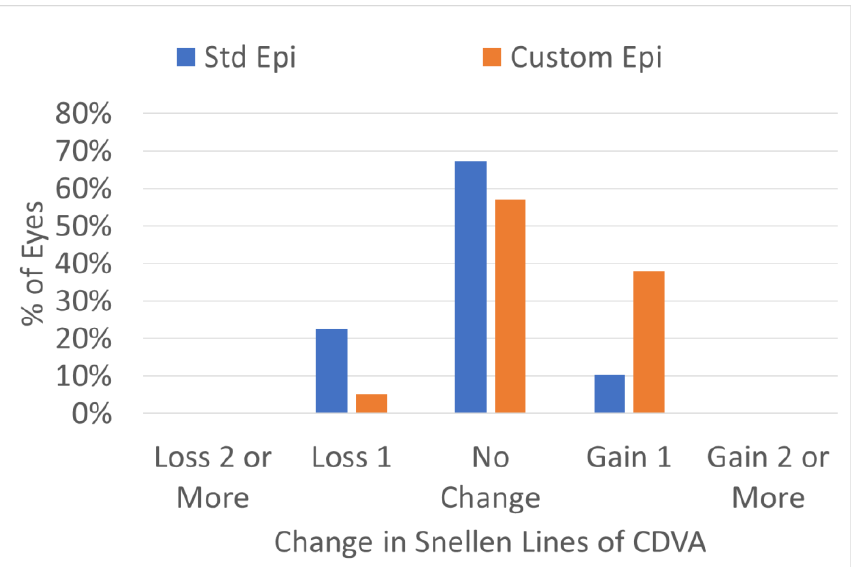
Figure 7. Safety change for preoperative CDVA vs. postoperative Snellen lines. No eye lost two or more CDVA lines in either group. More eyes in the customized epithelium profile group gained one line of CDVA.